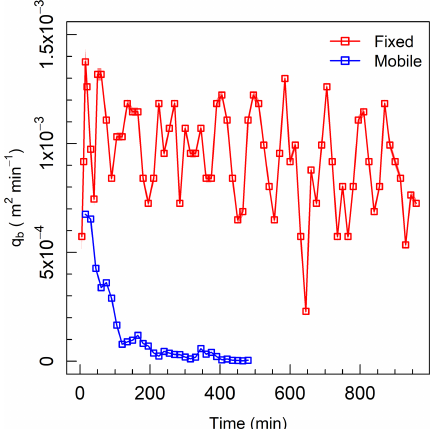
Figure 4. Sediment output rates, given as volumetric rates per unit